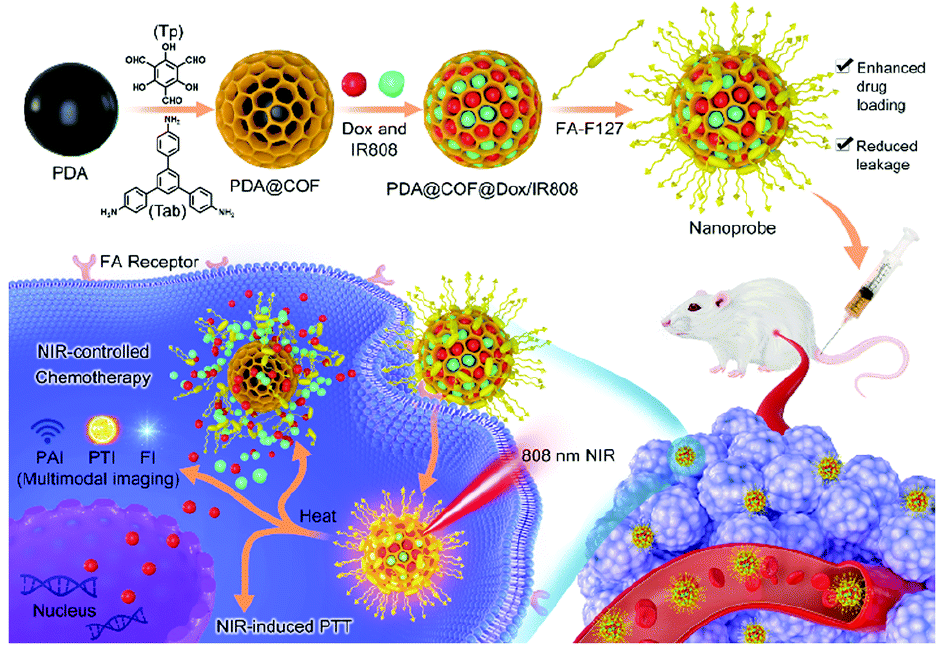
Figure 10. Schematic illustration of the preparation and in vivo multimodal imaging guided photothermal chemotherapy application of the nanoprobe [109]. Reprinted with permission from ref. [109]. Copyright 2021 Royal Society of